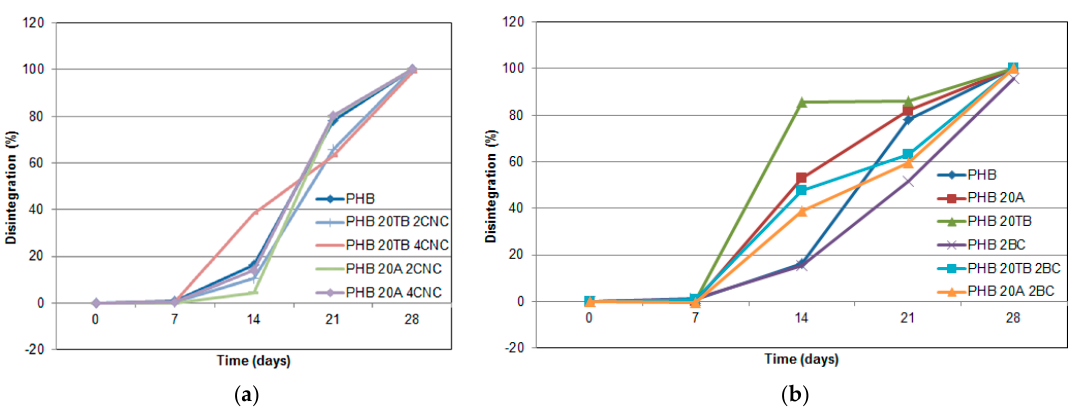
Figure 12. Disintegrability of CNC- ( a ) and BC-based ( b ) plasticized nanocomposites.